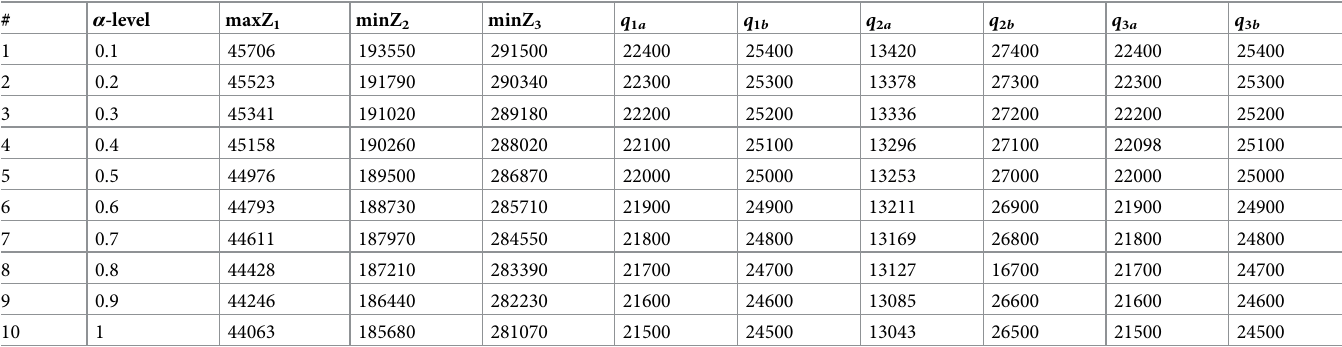
Table 13. Results for AUGMECON approach.